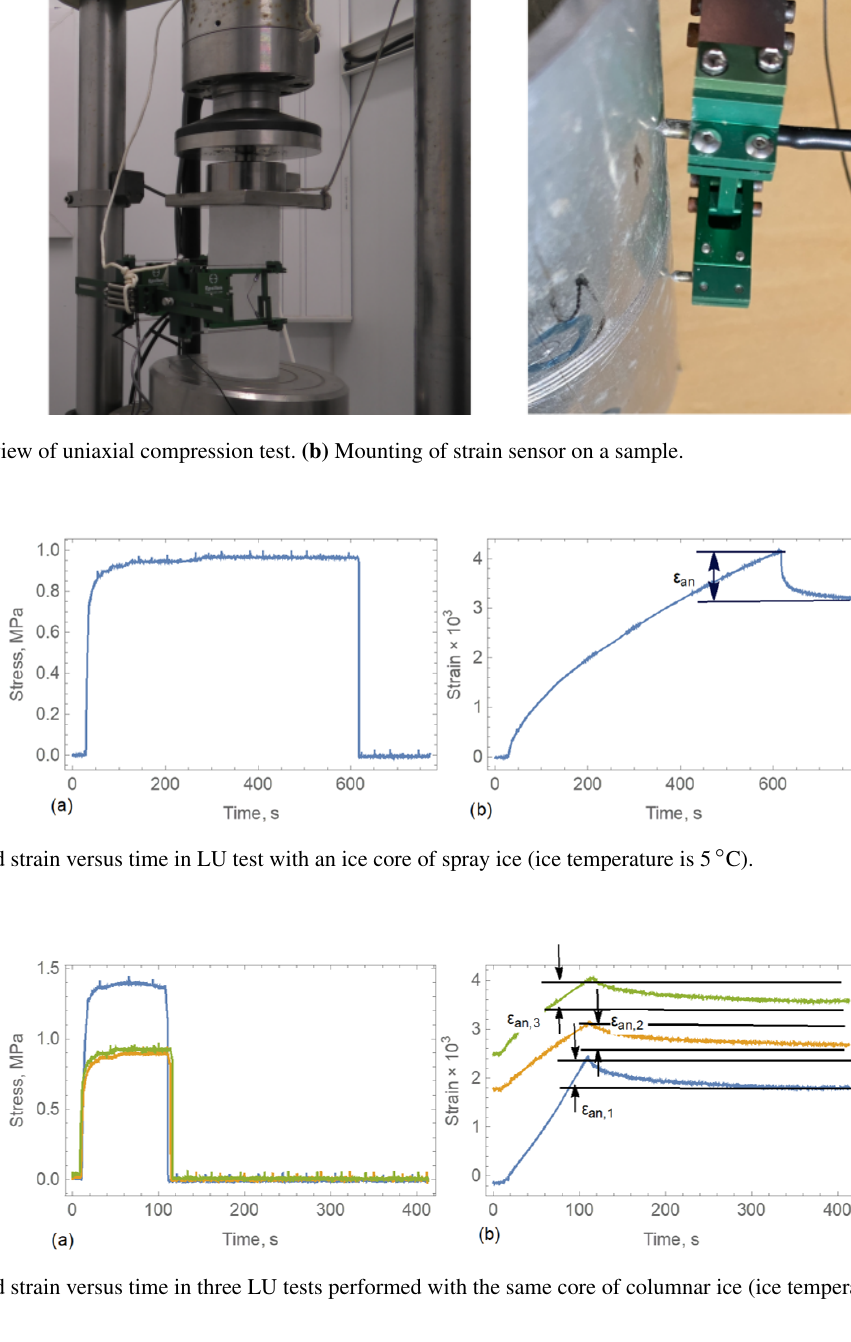
The Cryosphere, 15, 5557–5575,